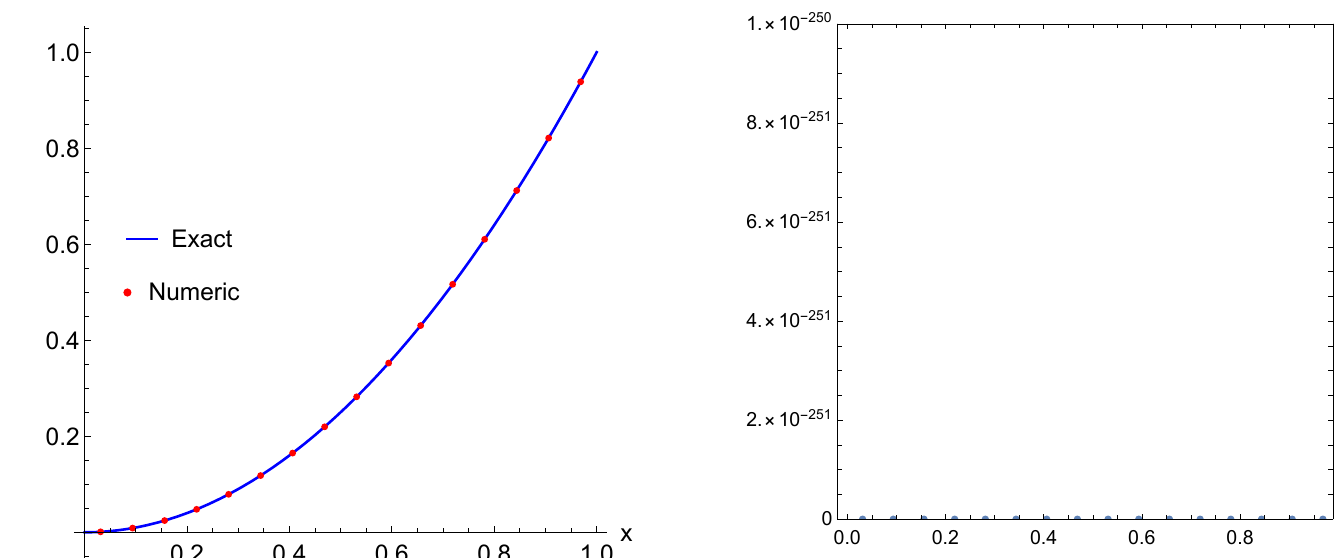
Figure 12. The numerical solution (points) with exact solution ( left ) and the absolute error computed for Example 9 ( right